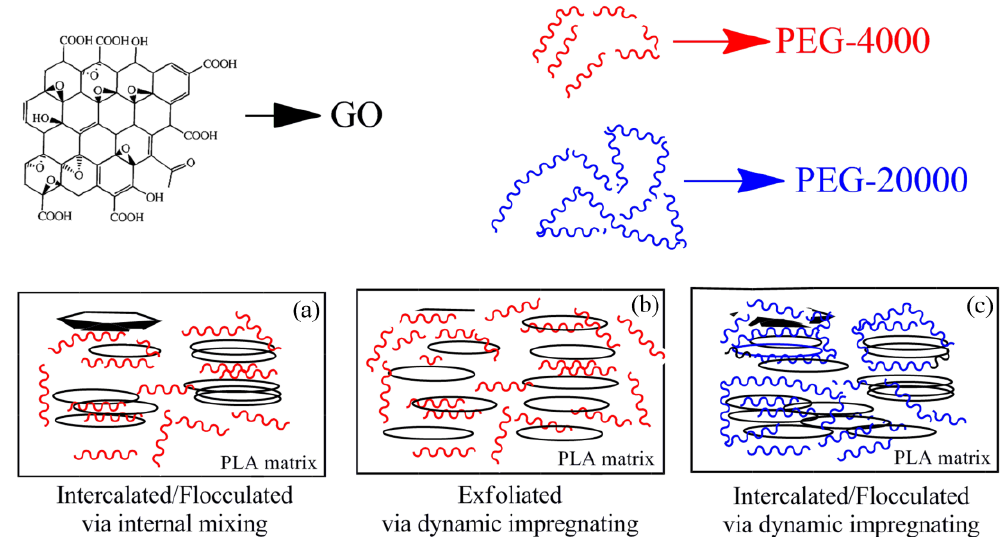
Figure 11. Physical model for dispersed morphologies of GO/PEG in PLA matrix with different molecular weight via dynamic impregnating and/or internal mixing, respectively. ( a ) represents GO/PEG-4000/PLA nanocomposite via internal mixing, ( b ) represents GO/PEG-4000/PLA nanocomposite via dynamic impregnating and ( c ) represents GO/PEG-20000/PLA nanocomposite via dynamic impregnating.